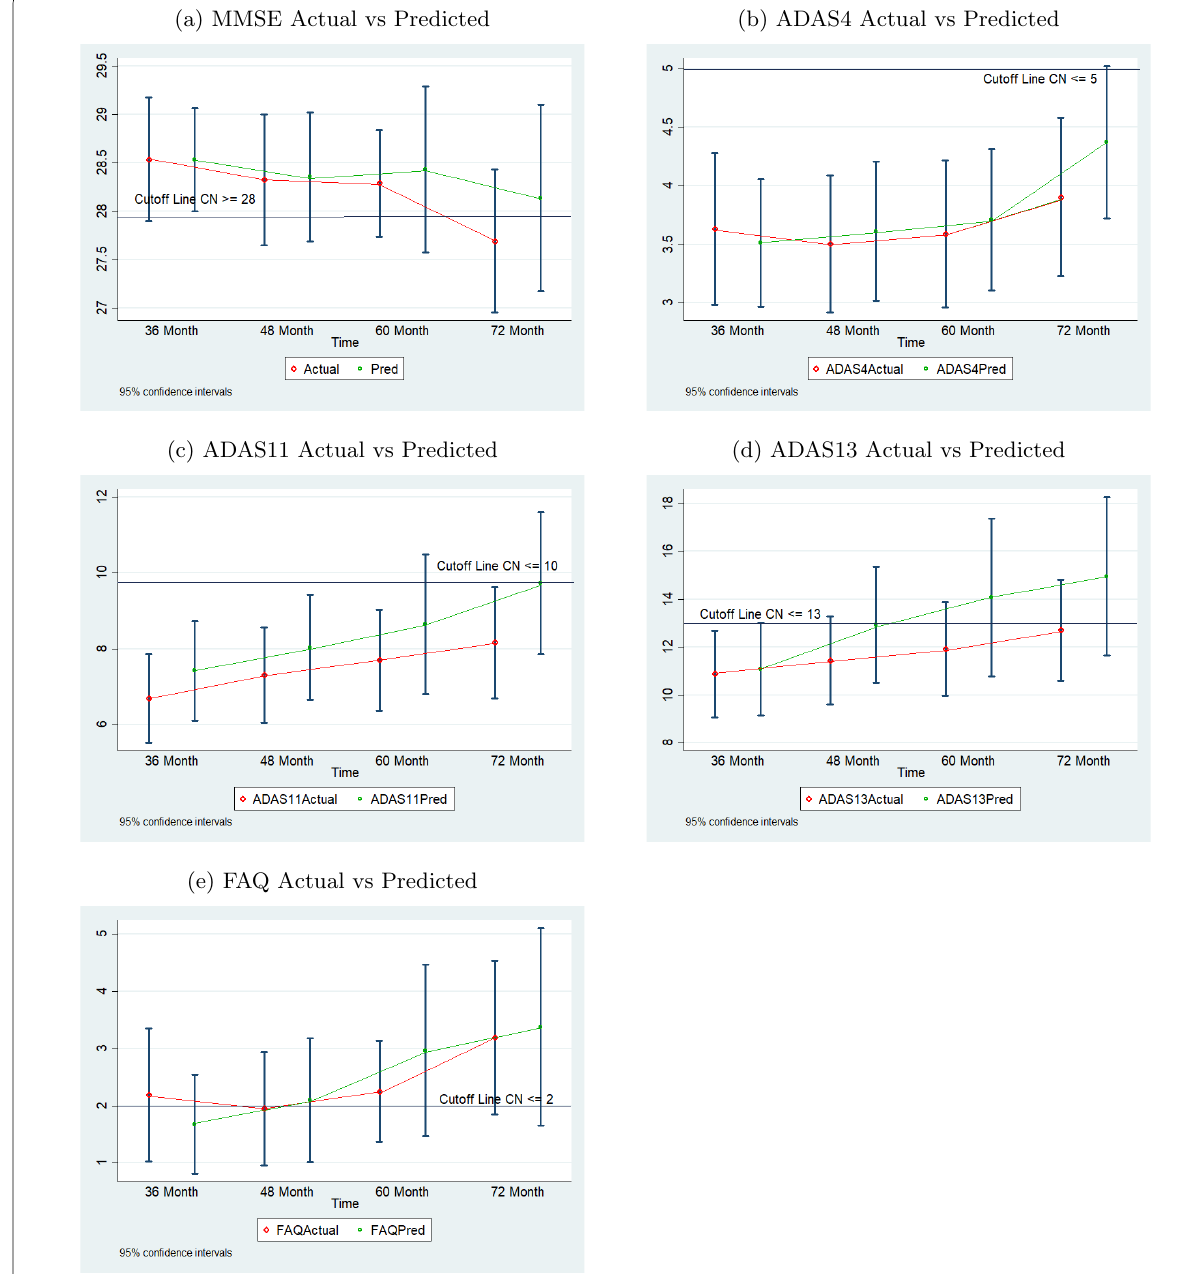
Fig. 13 95% confidence intervals of actual and predicted values for sequence prediction models for test data (with normal